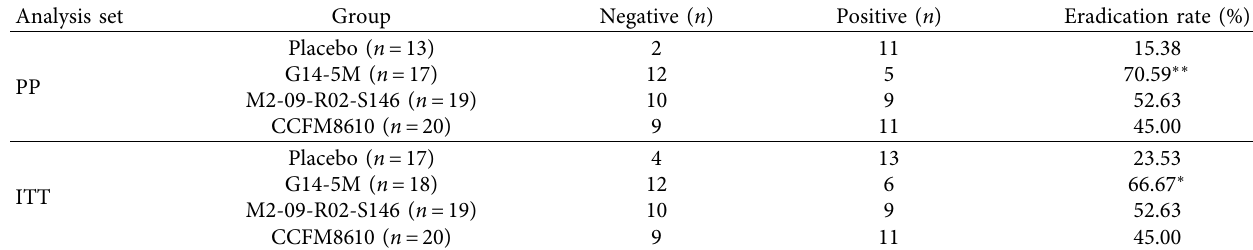
Table 3: Helicobacter pylori infection-eradication